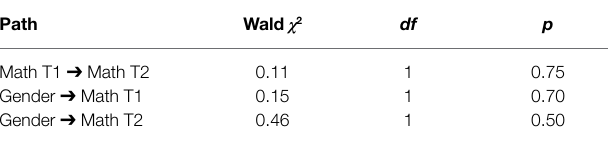
TABLE 3 | Significance of differences in standardized path coefficients between the high and low self-control capacity conditions. Path Wald χ 2 df